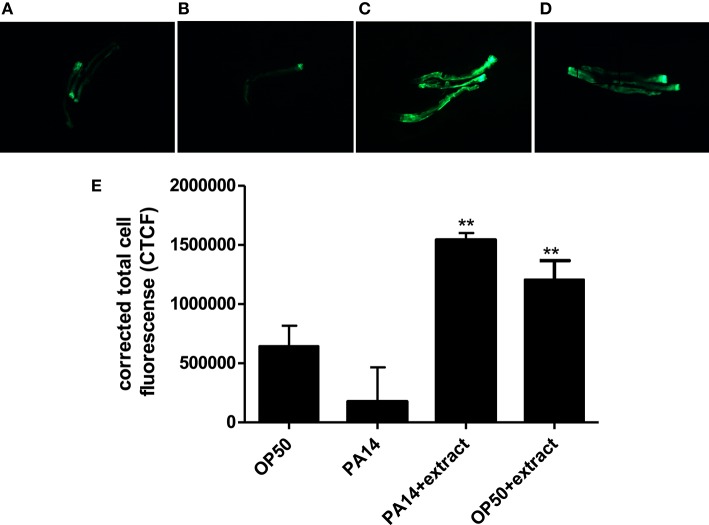
Induced expression of lys-7 in PA14 infected worms upon treatment with Streptomyces sp. CCB-PSK207 hexane partition. Representative fluorescence micrographs of worms after 24-h incubation with partition. (A) Worms fed on OP50, uninfected; (B) PA14-infected worms without extract treatment and (C) PA14-infected worms treated with 400 μgmL−1 hexane extract; (D) worms fed on OP50 and treated with 400 μgmL−1 hexane extract, uninfected. Worms were examined under Leica Microsystem M205 FA with magnification x127. “+” denotes anterior head region of the worms. (E) Corrected total cell fluorescence of lys-7 micrograph A, B, C, and D. Data were analyzed with the Image J software version 1.49. **Denotes significance (p<0.01, t-test) in comparison to the untreated control.